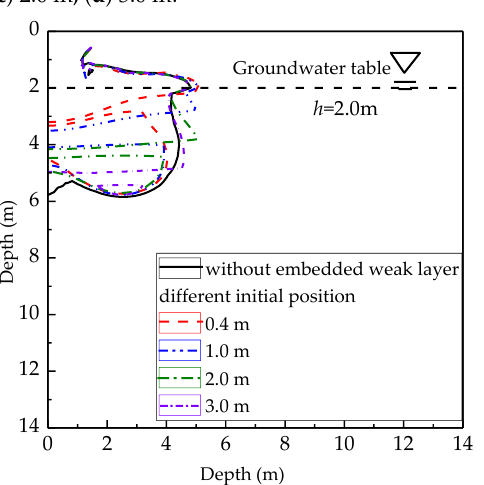
Figure 13. Cloud charts of I r for different initial position of embedded weak layer. ( a ) 0.4 m; ( b ) 1 m; ( c ) 2.0 m; ( d ) 3.0 m.